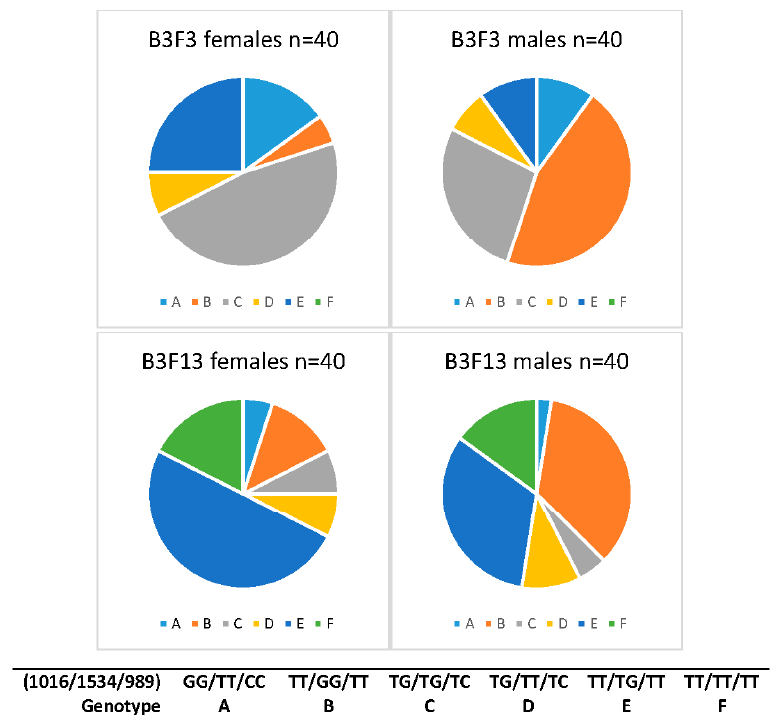
Figure 5. Changes in frequency of Vssc genotypes between B3F3 and B3 F13 (ten generations) of the IMR laboratory colony ( w AlbB infected) and differences between female and male Aedes aegypti .